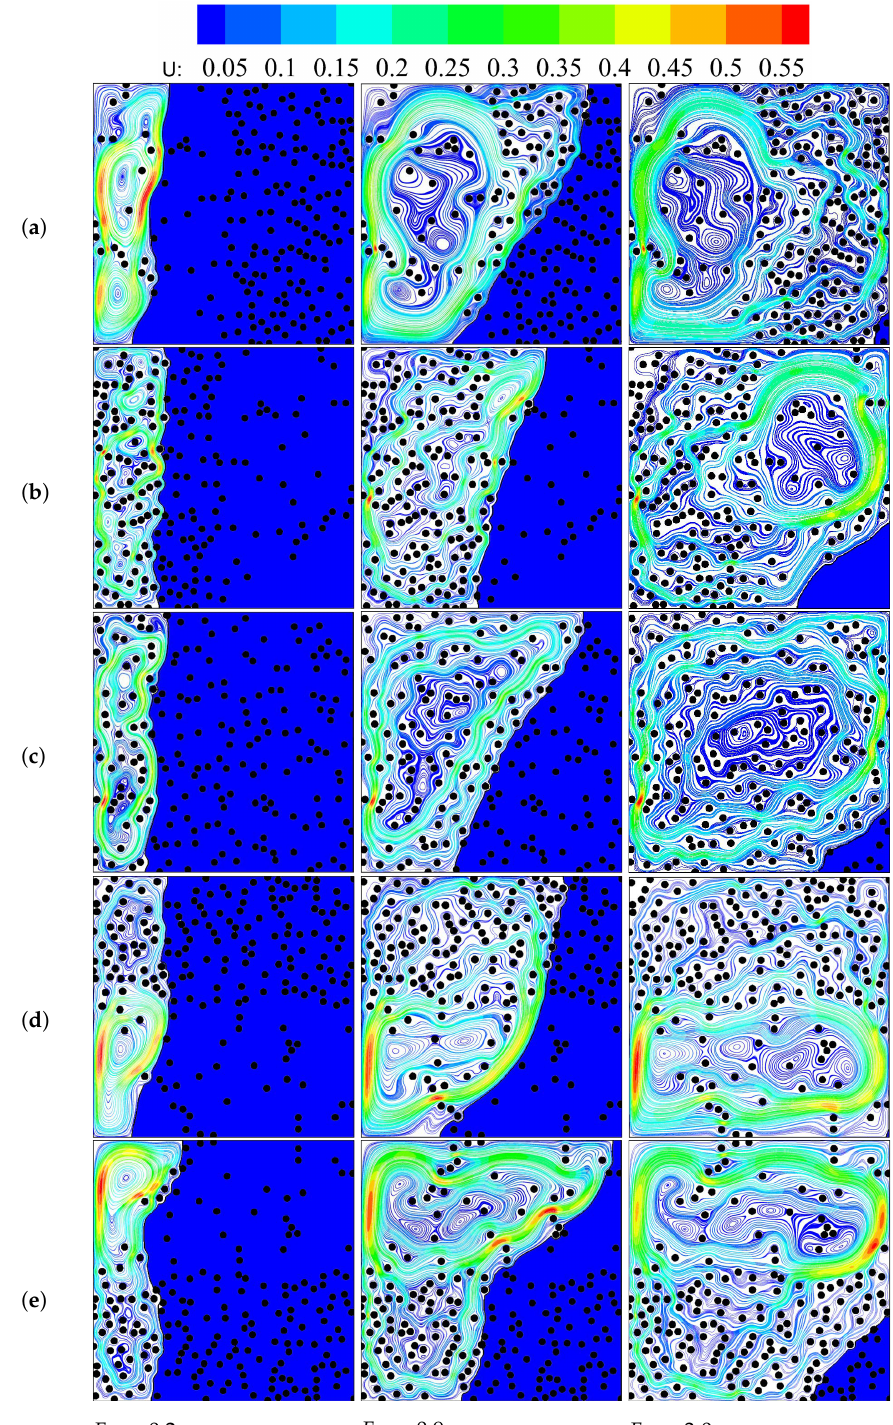
Fo = 0.2 Fo = 0.9 Fo = 3.0 Figure 4. The distribution of the liquid fraction for different gradient structures at Ra = 10 6 , in which Ste = 0.1, and Pr = 0.2: ( a ) Case A: negative gradient; ( b ) Case A: positive gradient; ( c ) Uniform gradient; ( d ) Case B: negative gradient; ( e ) Case B: positive